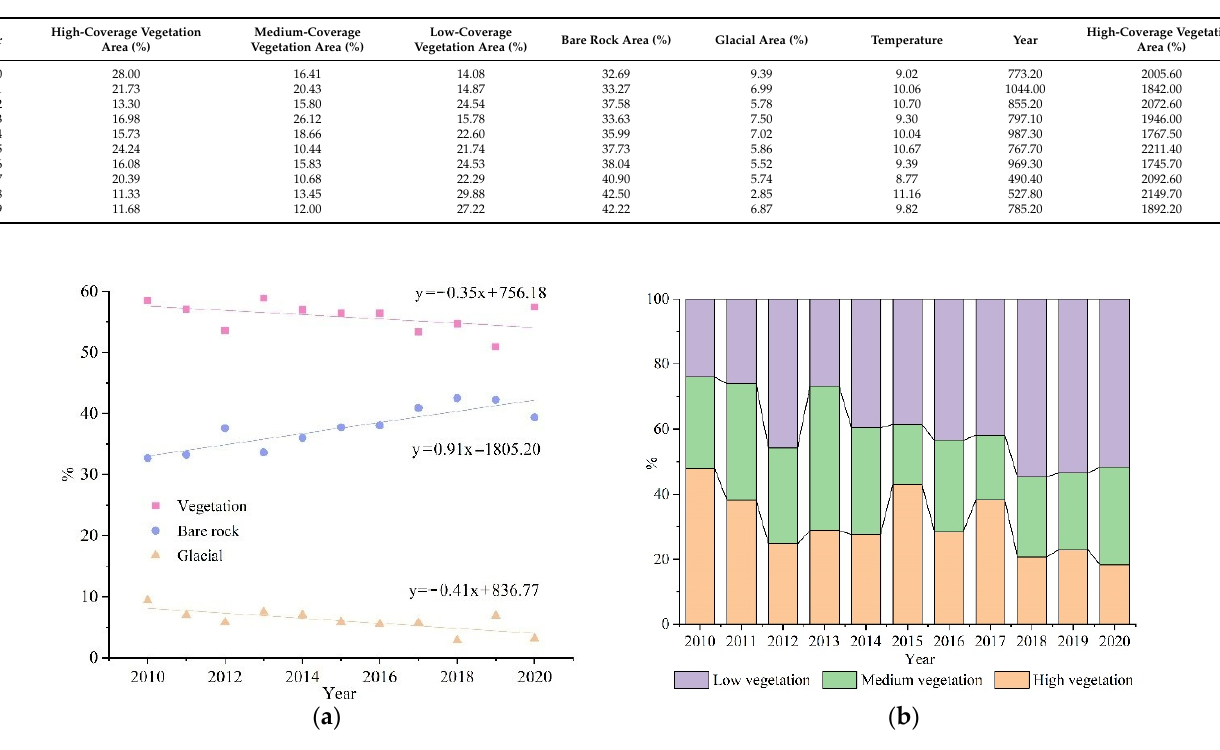
Figure 5. ( a ) Annual changes in landscape categories; ( b ) The changes in vegetation typologies. Table 3. Landscape classification and climate change indicators in Sobchaye.